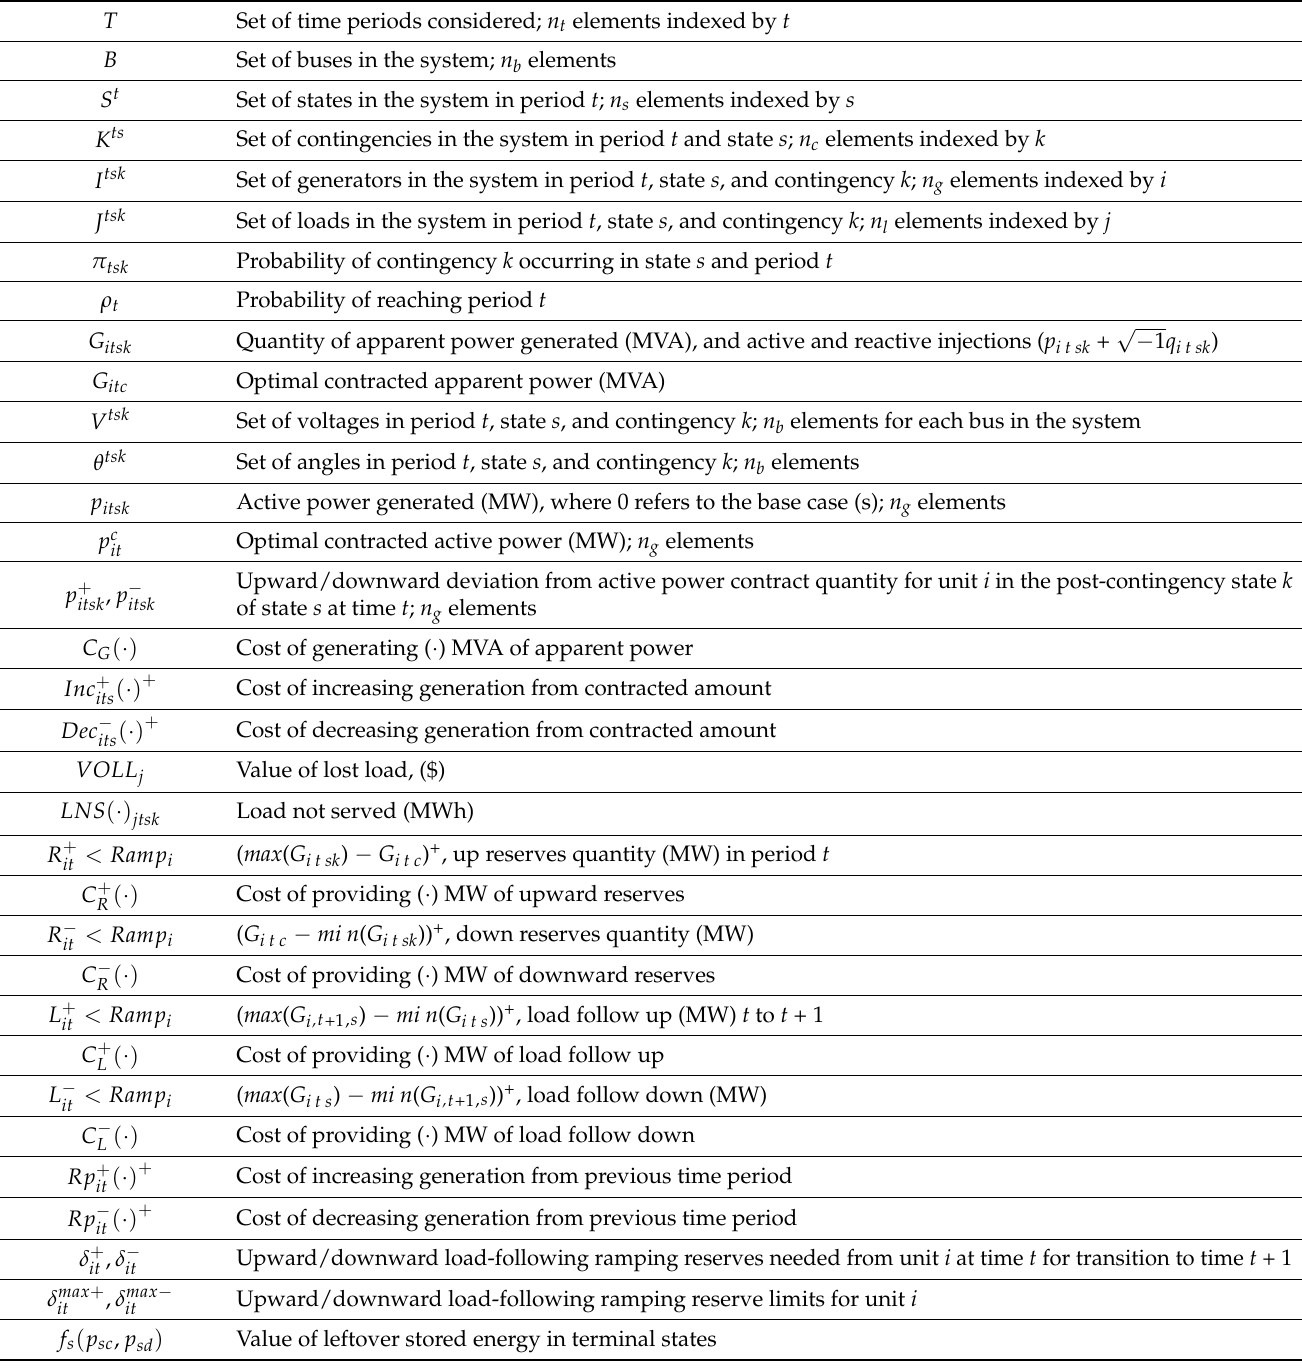
Table A1. Definition of variables in the objective function of